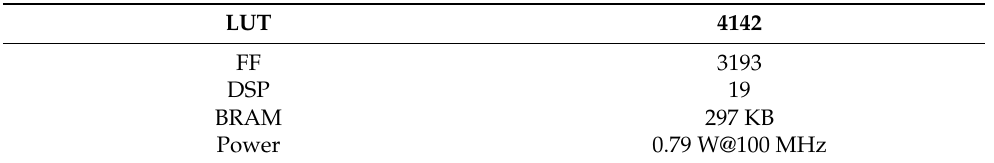
Table 3. Resource Utilization and Power Consumption of the Proposed Hardware Accelerator SoC Design on a Xilinx Zynq FPGA.